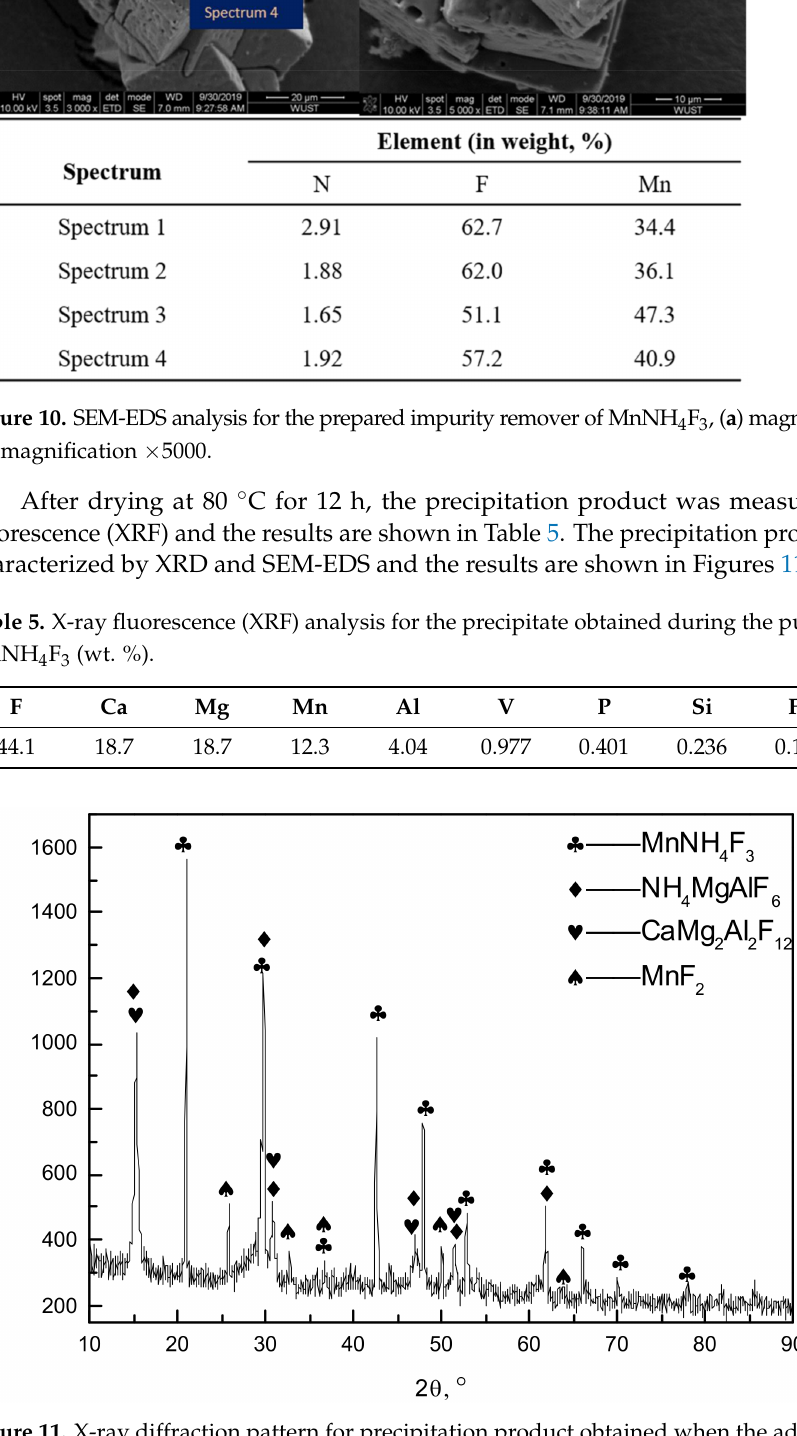
Figure 11. X-ray diffraction pattern for precipitation product obtained when the adding dosage of MnNH 4 F 3 was